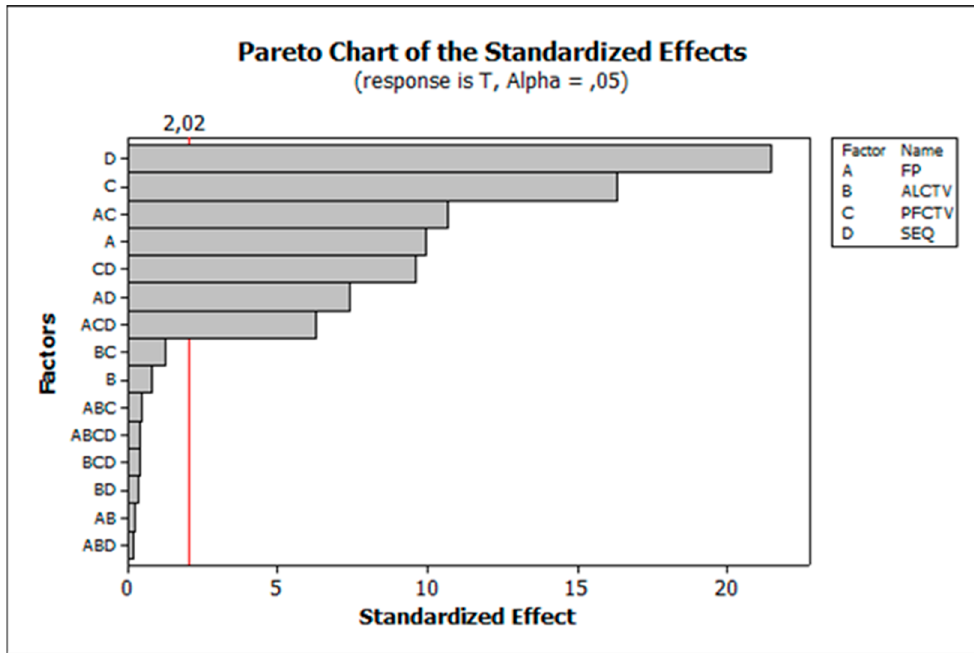
Figure 3. Pareto chart of the standardized effects of the inputs on T.